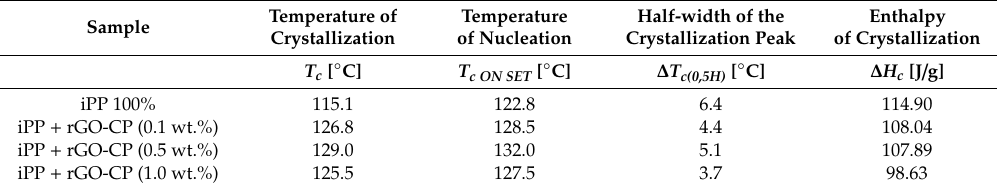
Figure 5. DSC curves during cooling of polypropylene without rGO-CP—black (1); polypropylene + rGO-CP (0.1%)—red (2); polypropylene + rGO-CP (0.5%)—blue (3); polypropylene + rGO-CP (1.0%)—green (4). Table 2. Parameters of polypropylene crystallization.